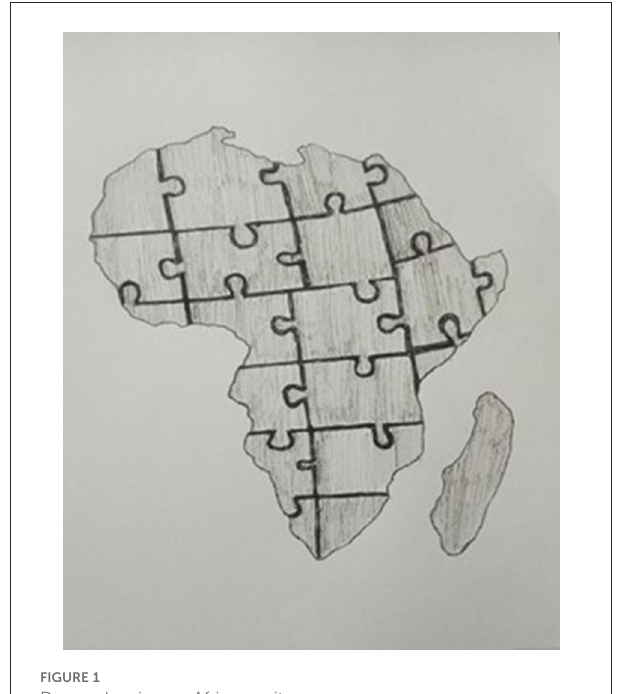
FIGURE1 Dream drawing on African